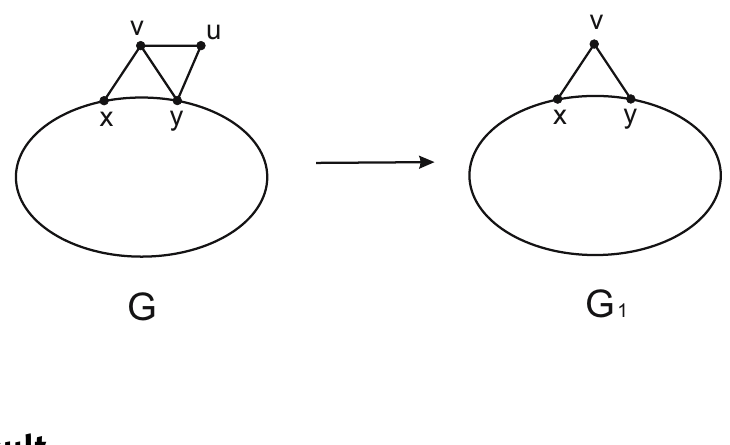
Figure 1: G and G 1